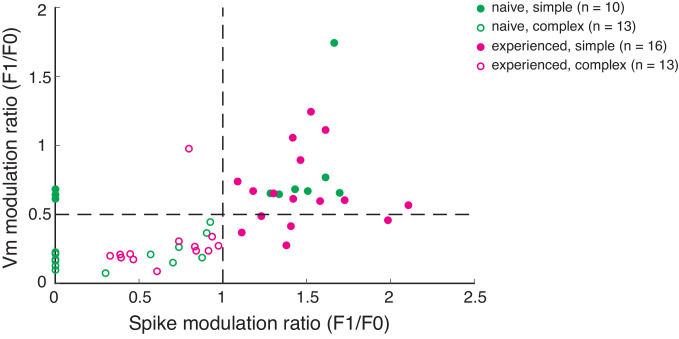
Scatterplot of spike and Vm modulation ratios (F1/F0) for allcells recorded.Cells with spike modulation ratio >1 from this figure were classified as simple cells. In the naive group, many neurons did not fire sufficient spikes to calculate a spike modulation ratio. Those neurons were plotted in this figure with a spike modulation ratio set to 0. Out of those neurons, those with Vm modulation ratio >0.5 were classified as simple cells.